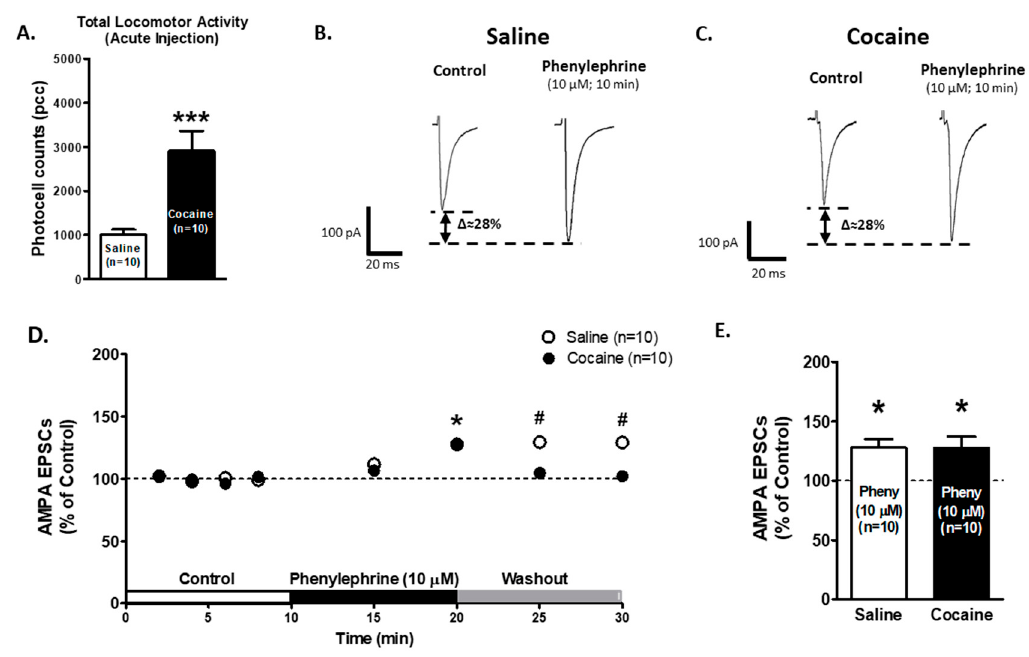
Figure 1. α 1-ARs-mediated e ff ect on AMPA EPSCs is preserved in ventral tegmental area (VTA) dopamine (DA) neurons after one cocaine / saline injection. ( A ) The bar graph shows total locomotor activity recorded from saline- (0.9%, white bar; n = 10) and cocaine-treated (15 mg / kg i.p., black bar; n = 10) animals. The locomotion of cocaine-treated animals was significantly increased when compared to saline-treated controls (Unpaired t -test p < 0.001). ( B , C ) Representative recordings from saline- and cocaine-treated animals, respectively, showing that phenylephrine superfusion (10 µ M, 10 min) induces a significant increase in AMPA EPSCs amplitude in VTA DA neurons in both groups. ( D ) A time course summary of phenylephrine’s e ff ect on AMPA EPSCs recorded from VTA DA neurons from saline- ( n = 10) and cocaine- ( n = 10) treated animals at 8 min from control recordings (2 min intervals), 5 and 10 min phenylephrine (10 µ M), and 5 and 10 min washout (One-way ANOVA,